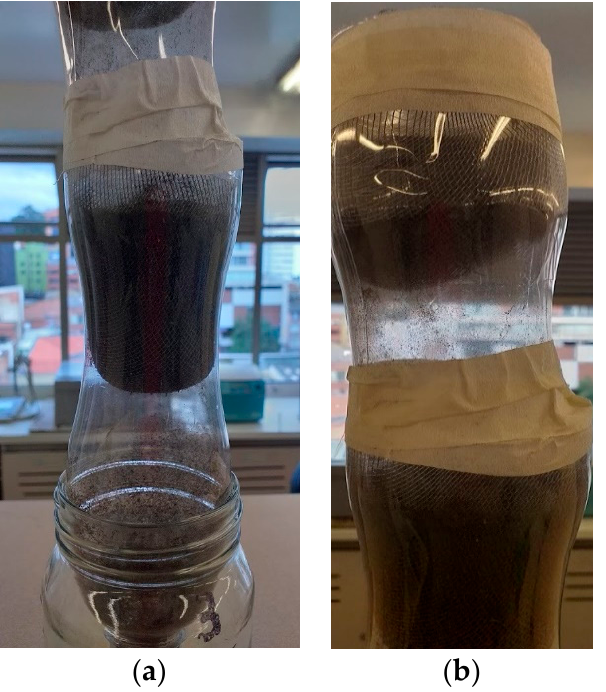
Figure 6. Biofilters used in the adsorption process: E crassipes (EC) ( a ); E crassipes with iron (EC + Fe) ( b ). Experimental